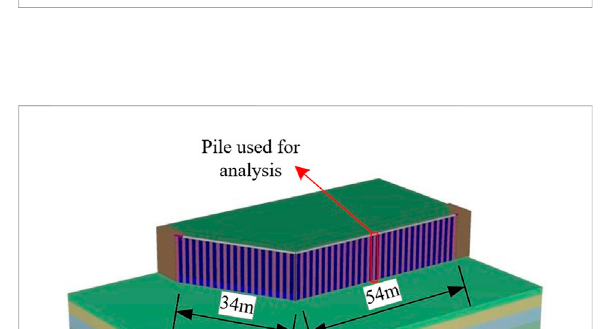
FIGURE 8 Cross section of the supporting